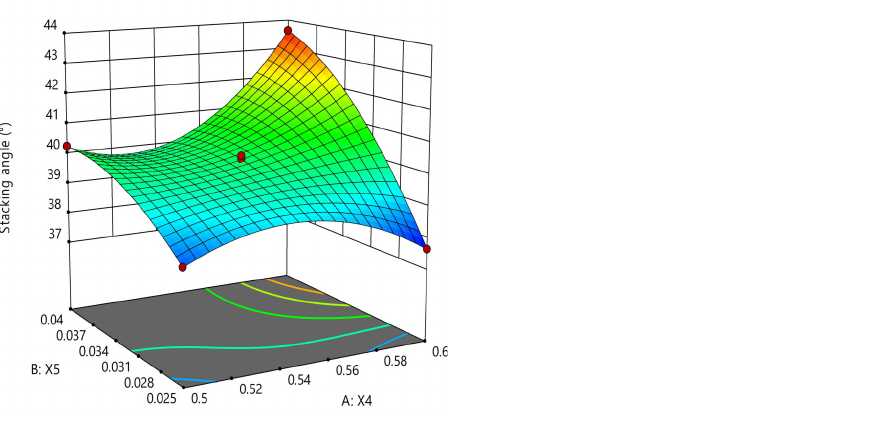
Figure 5. Response surface of the stacking angle of tobacco strips.